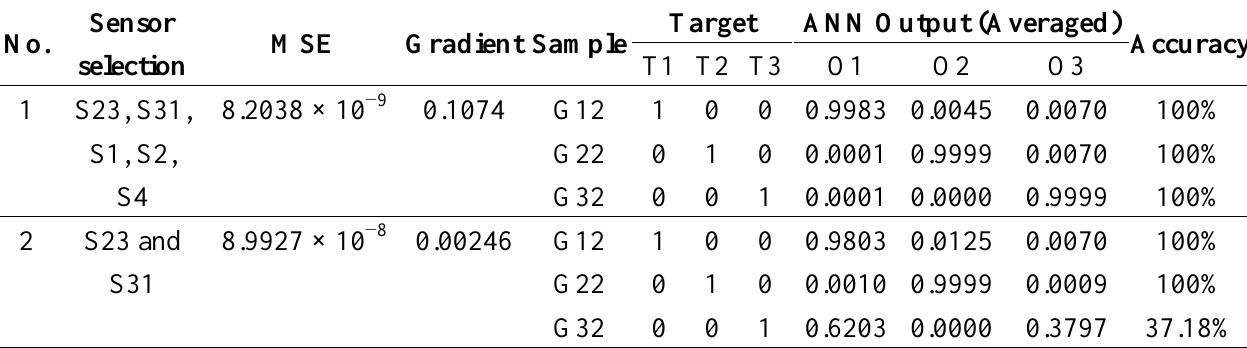
Table 5. The comparison performance of ANN using selected